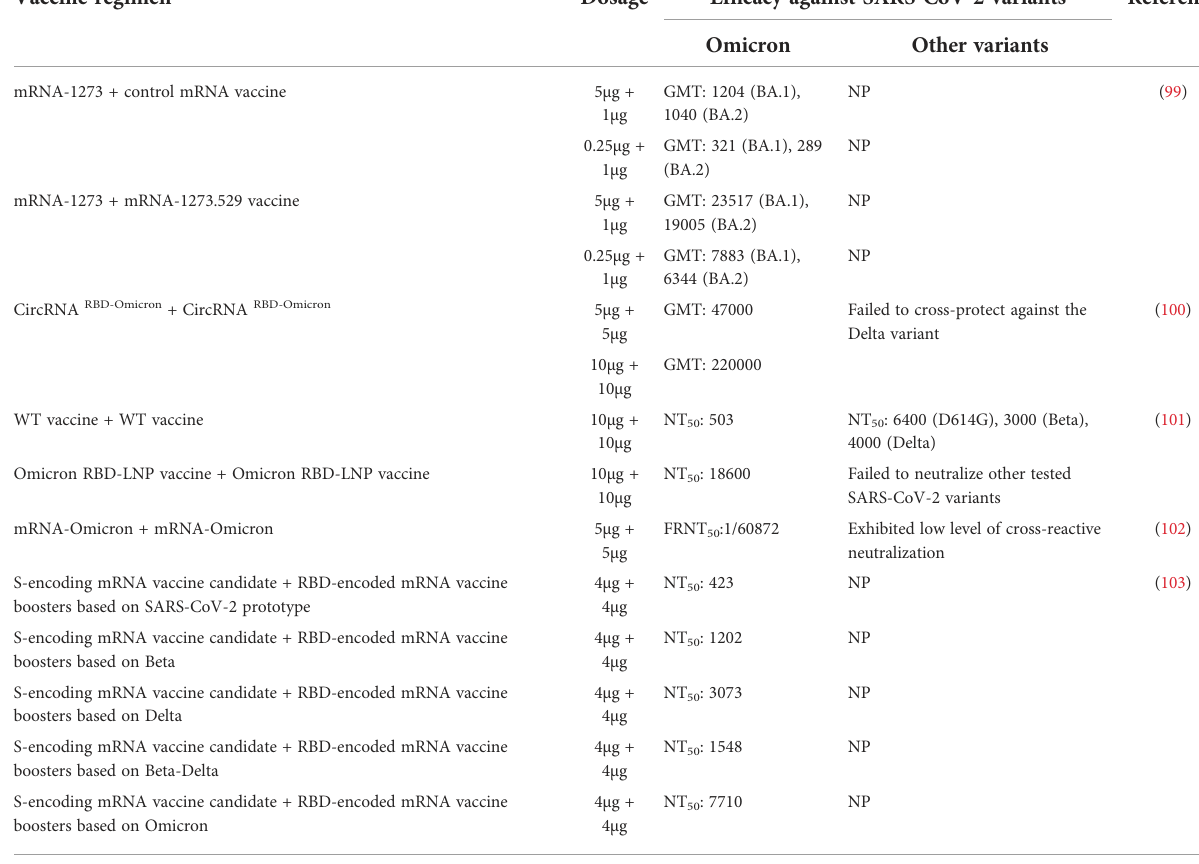
TABLE 3 Ef fi cacy of Omicron vaccine against SARS-CoV-2 variants. Vaccine regimen